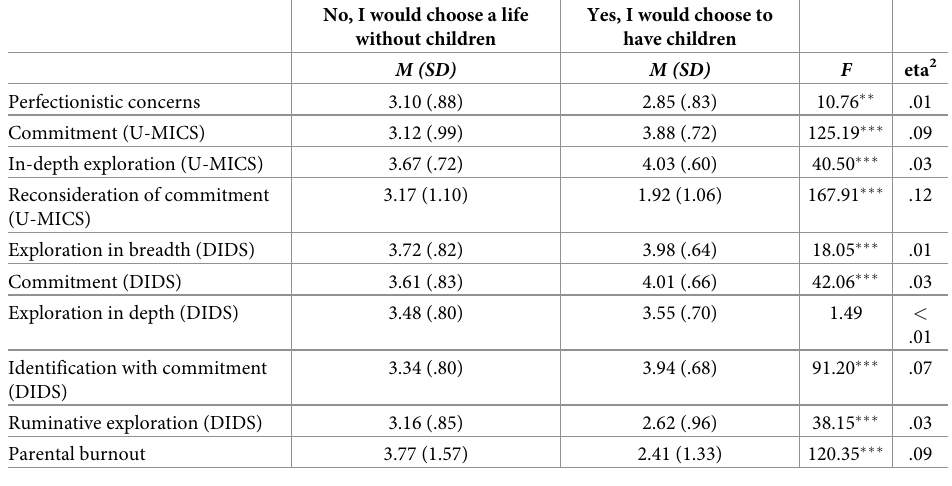
Table 10. Mean differences between the parents regretting and not regretting parenthood in Study 2. No, I would choose a life Yes, I would choose to without children have children M (SD) M (SD) F eta 2 Perfectionistic concerns 3.10 (.88) 2.85